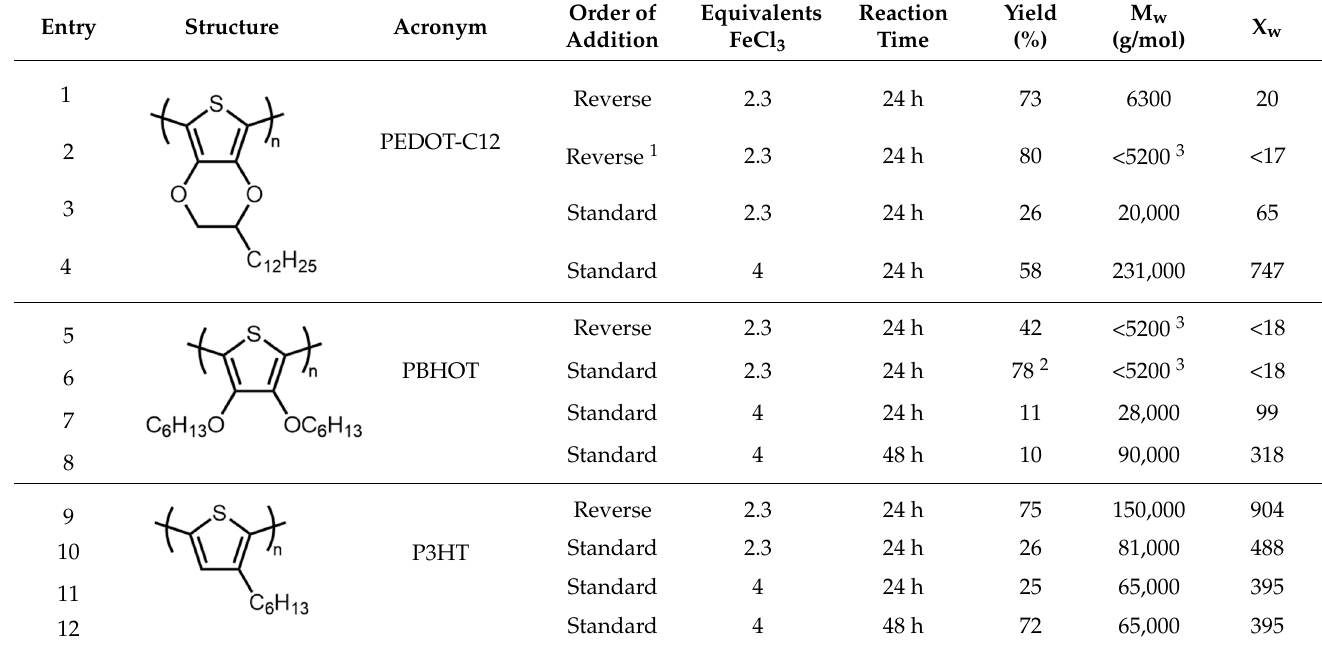
Below the lower limit of the calibrated region of the analytical column.